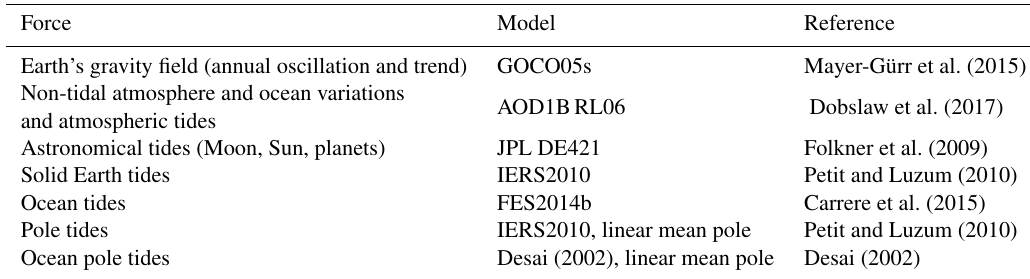
Table 1. Models used to reduce the temporal gravity